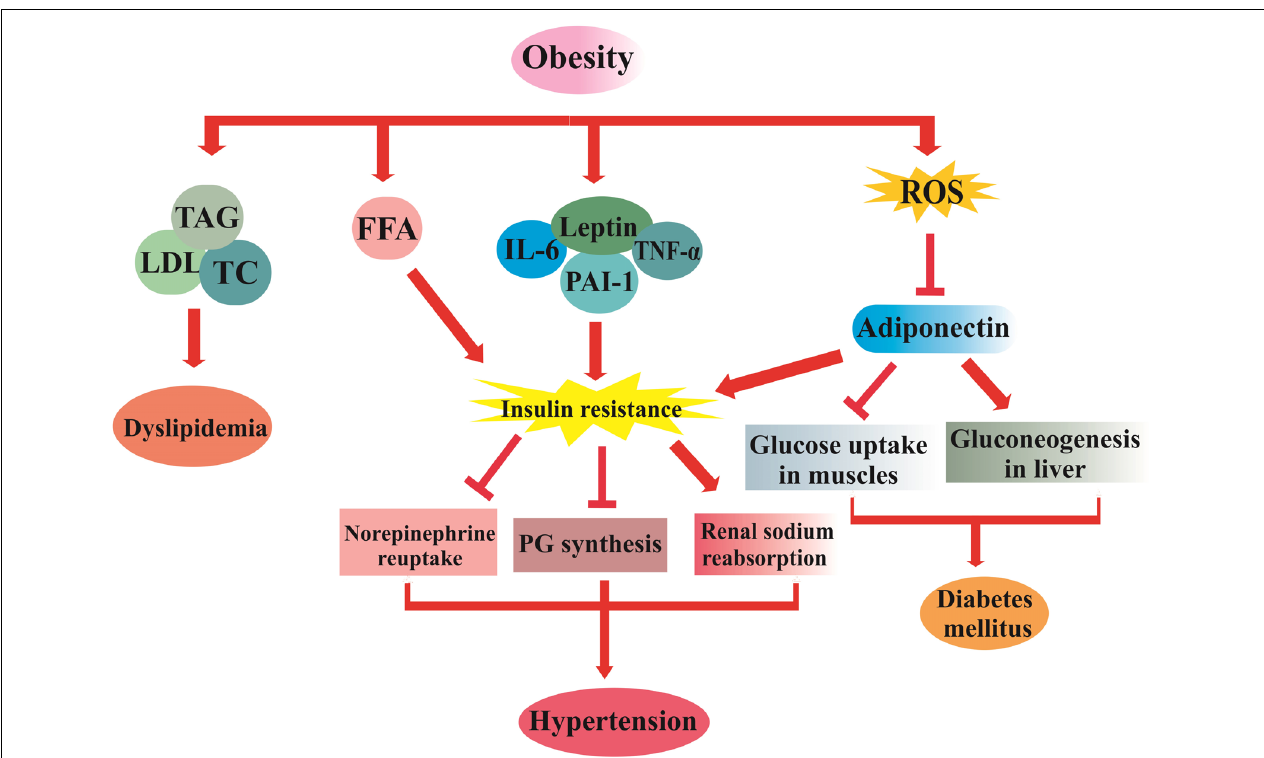
FIGURE 1 | The pathophysiological mechanism of MetS. TNF α , tumor necrosis factor; PAI-1, plasminogen activator inhibitor-1; IL-6, interleukin 6; FFA, free fatty acid; PG, prostaglandin; TAG, triacylglycerol; LDL-C, low density lipoprotein; TC, total cholesterol; ROS, reactive oxygen